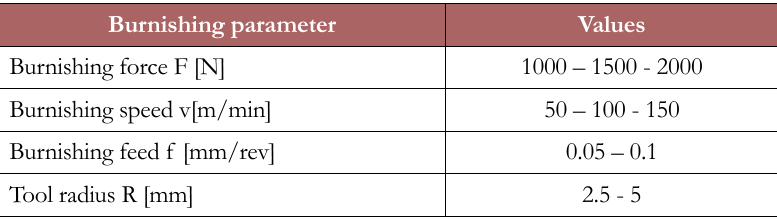
Table 1. Burnishing process parameters employed into experimental campaign